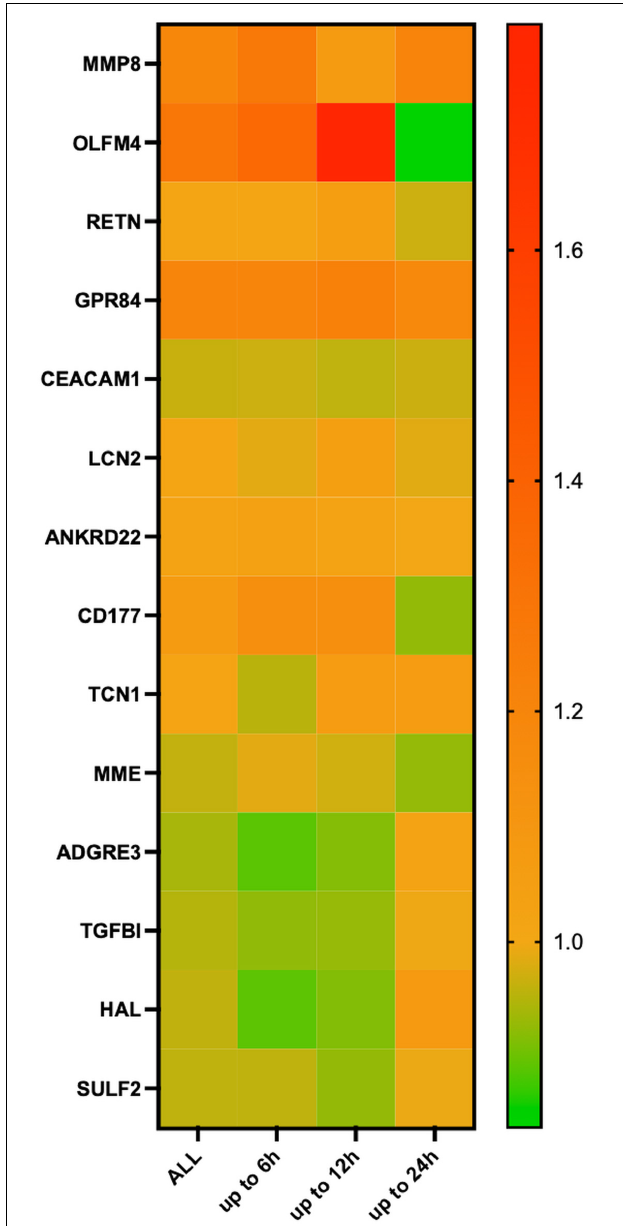
FIGURE 3 | Heatmap of relative changes in means in log2 normalized count in mRNA markers, according to time point of tissue harvesting. Figure legend: 8 animals available for analysis at 6 h (Ph1 n = 5, Ph2 n = 3), 7 at 12 h (Ph1 n = 4, Ph2 n = 3) and 8 animals at 24 h (Ph1 n = 5, Ph2 n = 3). Relative changes shown on the right y -axis were calculated as log2-normalized count of OA-IV-LPS divided by log2-normalized count of OA for each time